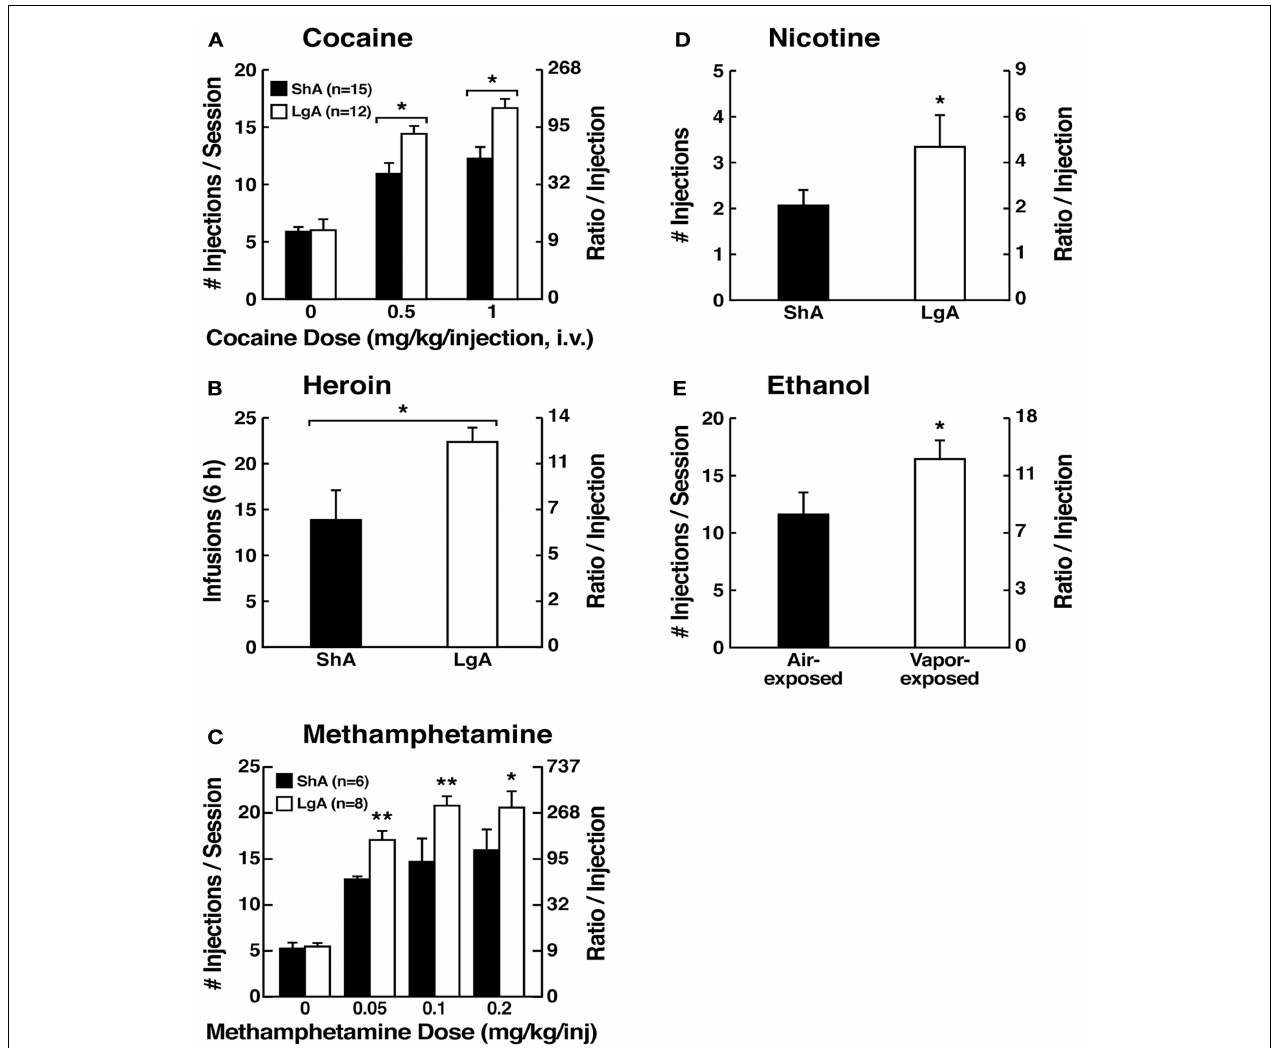
ended when rats did not achieve reinforcement within 1h. * p < 0.05, ** p < 0.01, LgA significantly different from ShA [Modified from Ref. (188)]. (D) Breakpoints on a progressive-ratio schedule in long-access (LgA) rats that self-administered nicotine with 48h abstinence between sessions. LgA